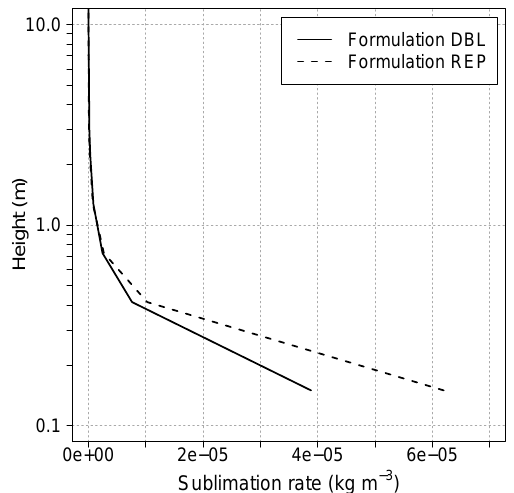
Fig. 6. Vertical profile of local sublimation rate simulated after 20min for U 5m = 16ms − 1 . Two different formulations of the sub- limation rate are tested: DBL (double-moment) and REP (represen- tative radius) (see Sect. 5.1 for more